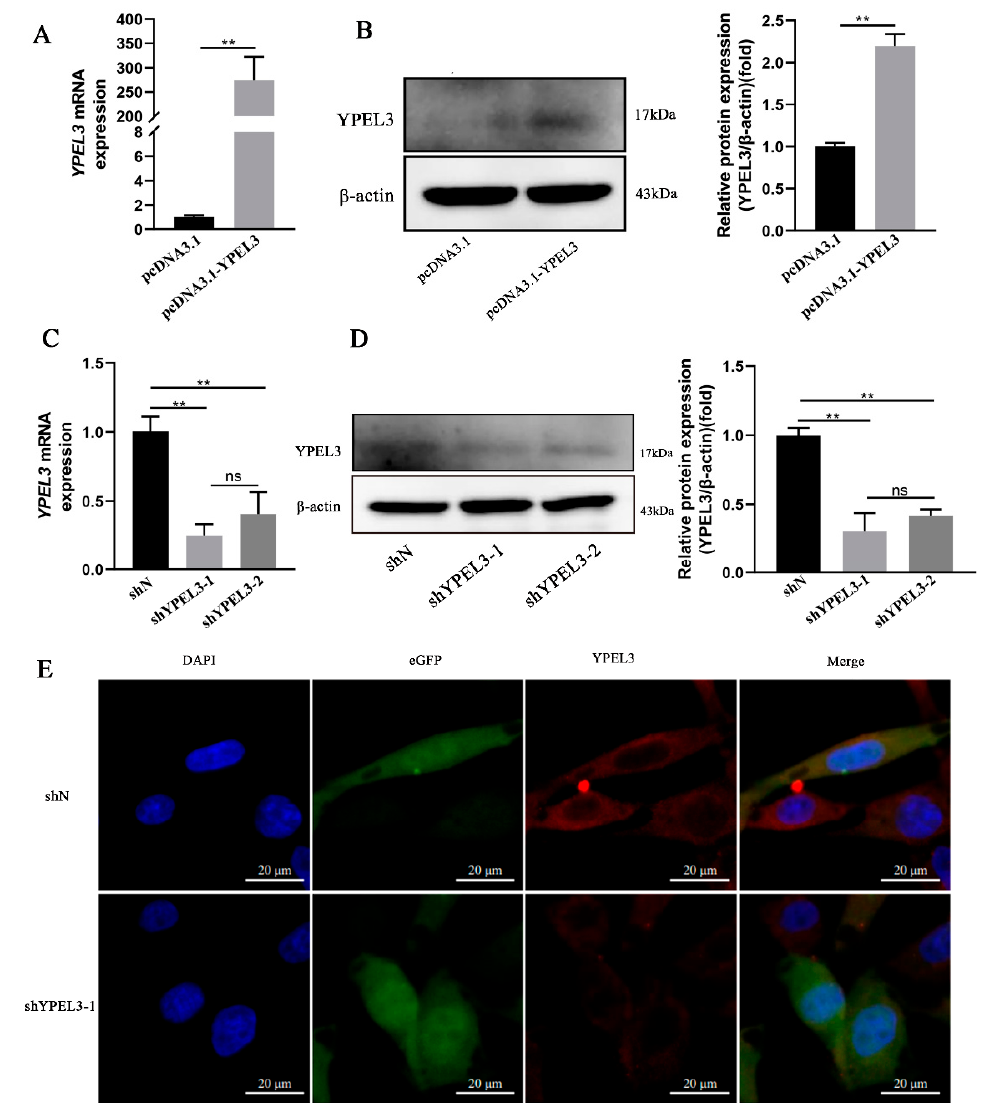
Figure 2. Confirmation of silencing and overexpression of YPEL3 in gEECs. ( A ) Real-time quantitative PCR analysis of YPEL3 mRNA overexpression efficiency in gEECs transfected with pcDNA3.1 and pcDNA3.1-YPEL3 for 48 h. ( B ) Western blot analysis of YPEL3 protein overexpression efficiency in gEECs transfected with pcDNA3.1 and pcDNA3.1-YPEL3 for 48 h. ( C ) Real-time quantitative PCR analysis of YPEL3 mRNA levels in gEECs transfected with shN and shYPEL3 for 48 h. ( D ) Western blot analysis of YPEL3 protein overexpression efficiency in gEECs transfected with shN and shYPEL3 for 48 h. ( E ) Confocal microscope images of YPEL3 expression in gEECs transfected with shN and shYPEL3 for 48 h. Scale bars = 20 µ m. ** p < 0.01, ns, not significant ( p > 0.05).